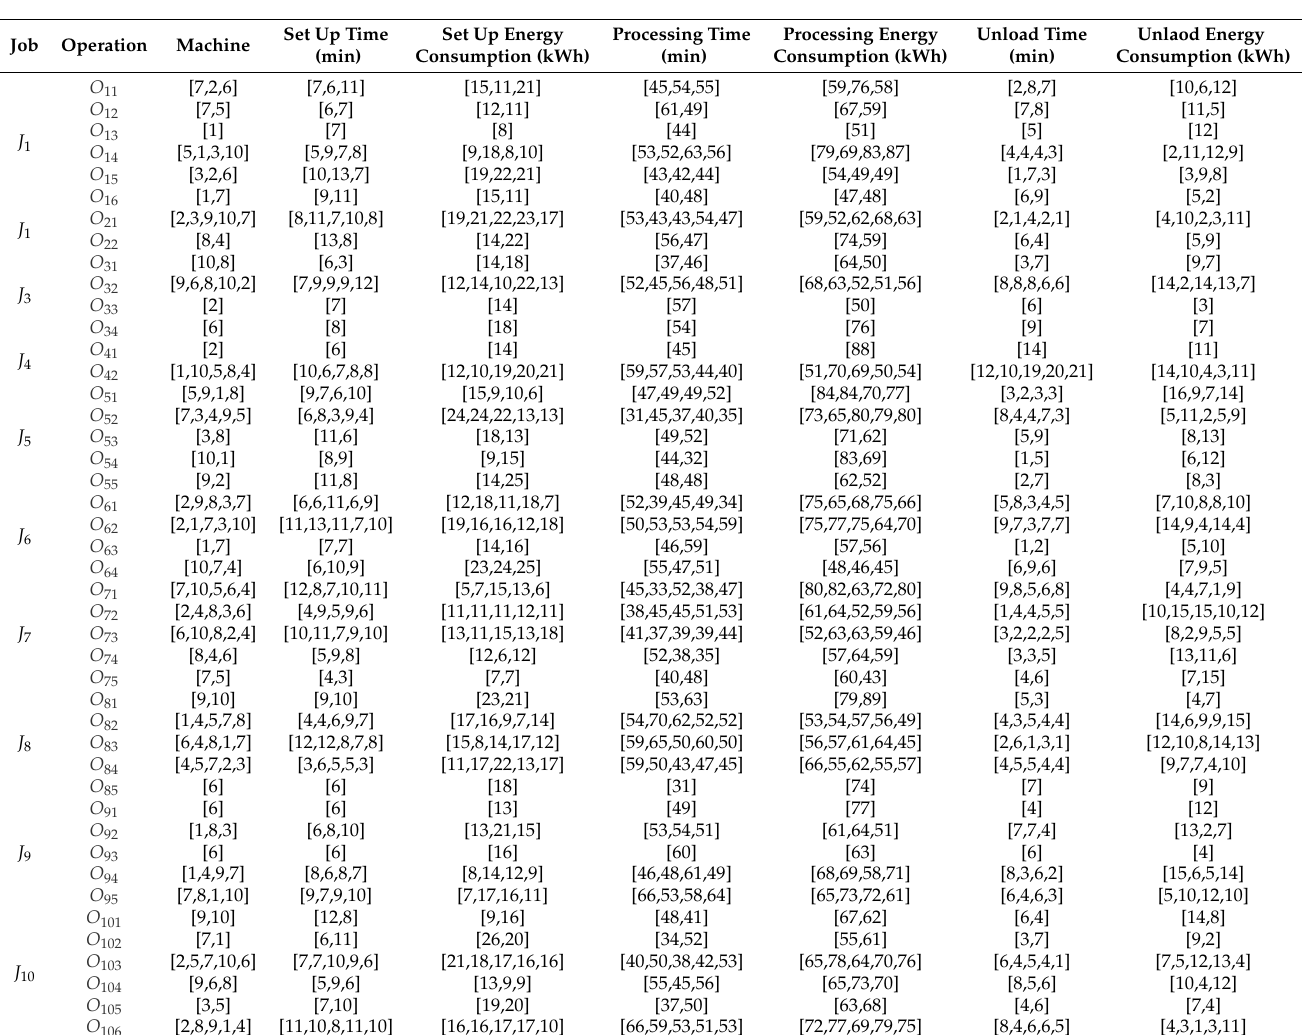
Table 8. The job shop information of Instance